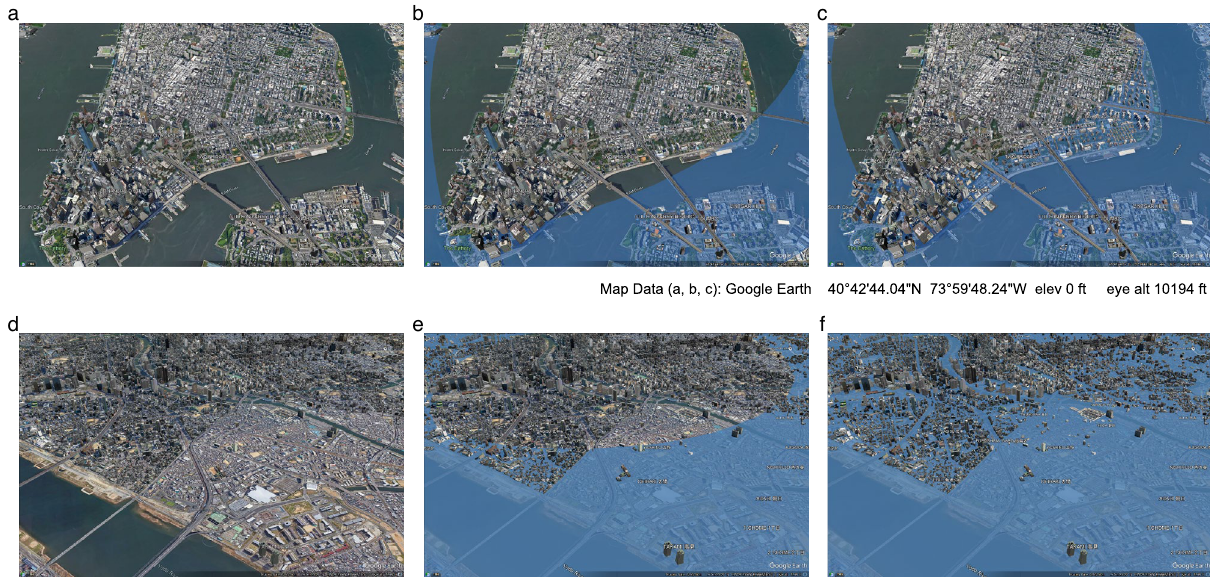
Figure 5. The 3D Google map simulation for regional mean sea level increase ranging from 0, to 1 and finally to 2 m for New York City ( a – c ) and Osaka ( d – f ) respectively, from its current level. According to our analysis, the New York City regional mean sea level will rise to 680.20 mm, 867.79 mm and 1269.97 mm higher than its current level under the COP26, unrestricted, and SSP5-8.5 scenarios respectively. The Osaka regional mean sea level will rise to 739.75 mm, 939.49 mm and 1366.68 mm higher than its current level under the COP26, unrestricted, and SSP5-8.5 scenarios,